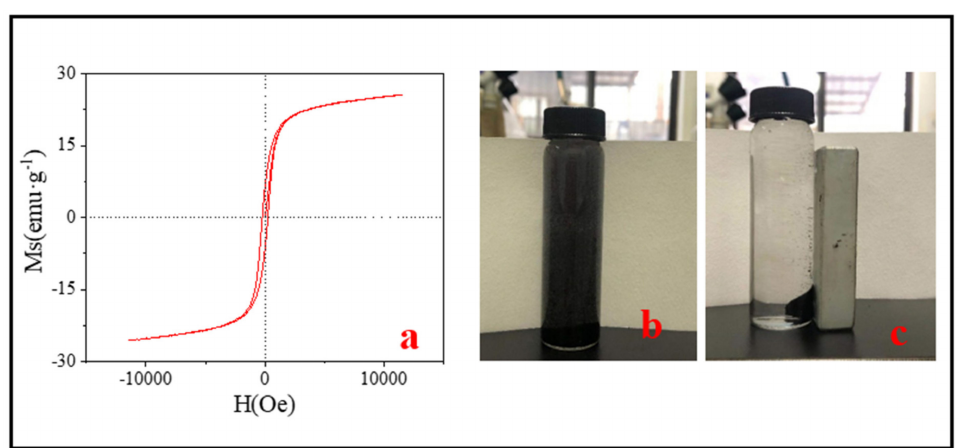
Figure 4. ( a ) The VSM results of SMB; ( b ) Pre-magnetic separation; ( c ) after magnetic separation. According to the IUPAC classification, the N 2 adsorption–desorption isotherms of BC and SMB both belong to type IV isotherms with hysteresis loops of type H3 (Figure 5a,c). In addition, the average pore size of the samples can be obtained from the BJH (Barrett, Joyner, and Halenda) pore size distribution chart (Figure 5b,d). All the specific surface areas and the average pore diameters were marked in Figure 5. The BET of BC and SMB were 70.64 m 2 · g − 1 and 20.19 m 2 · g − 1 , respectively. In addition, the average pore diameters were 9.72 nm and 13.01 nm, respectively. This indicated that BC and SMB were both mesoporous materials.